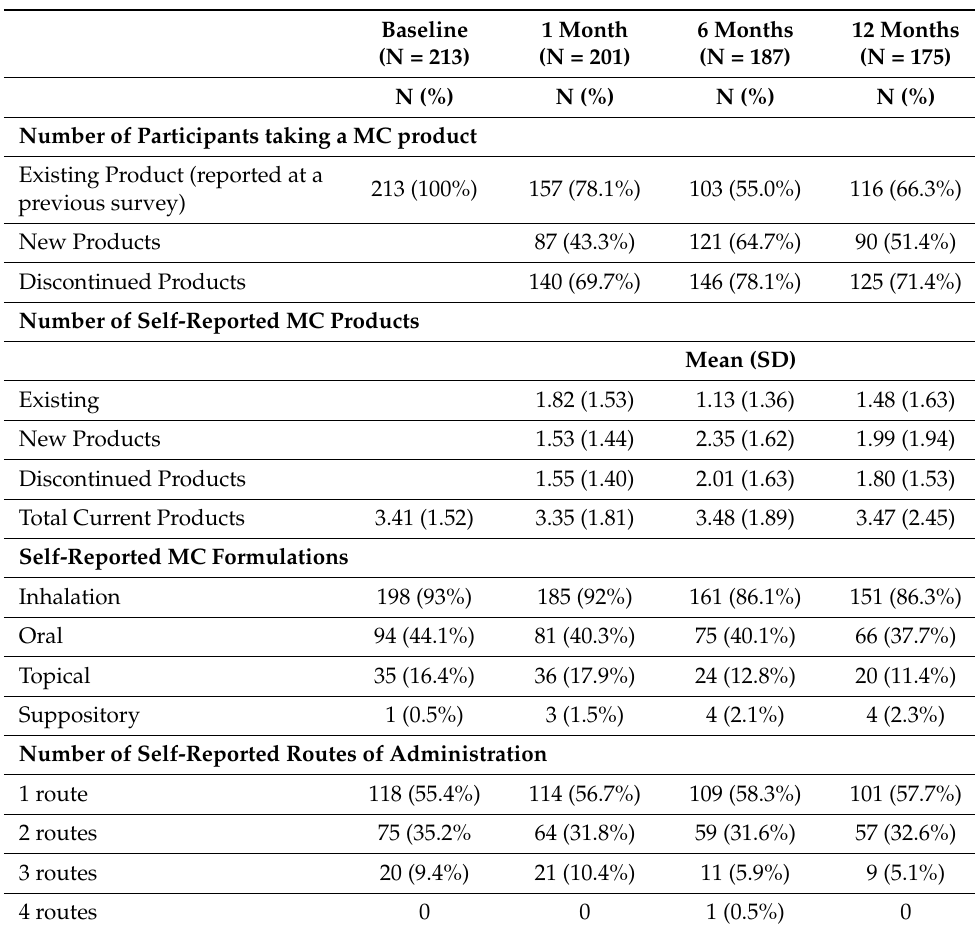
Table 2. Medical Cannabis Usage.